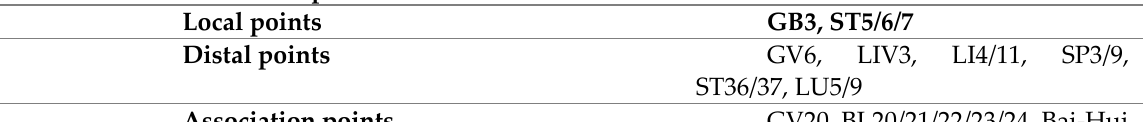
Table 2. Acupoints used Local